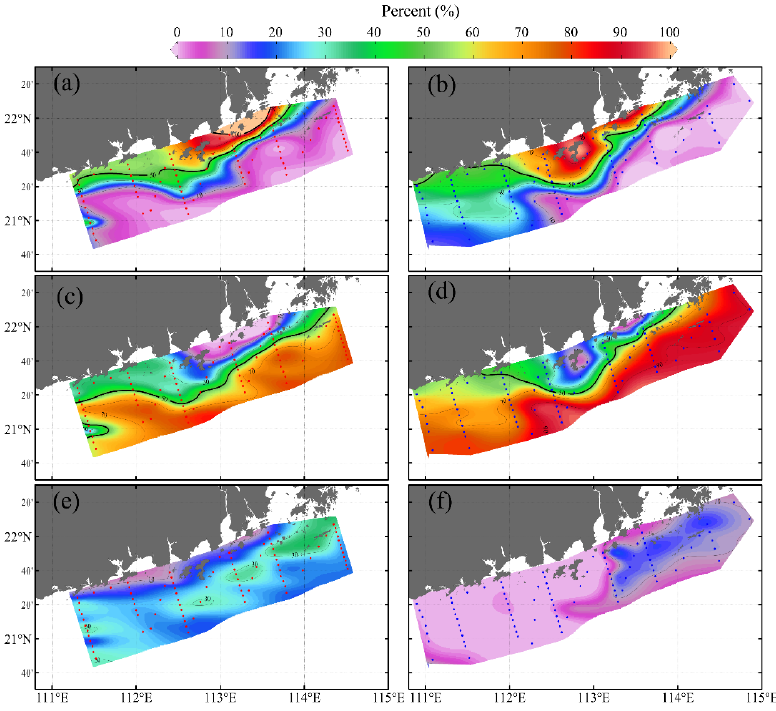
Figure 4. Water mass contributions (%) of PRDW ( a , b ), SCSSW ( c , d ) and SCSSUW ( e , f ) at the surface for the April ( a , c , e ) and May ( b , d , f ) cruises.